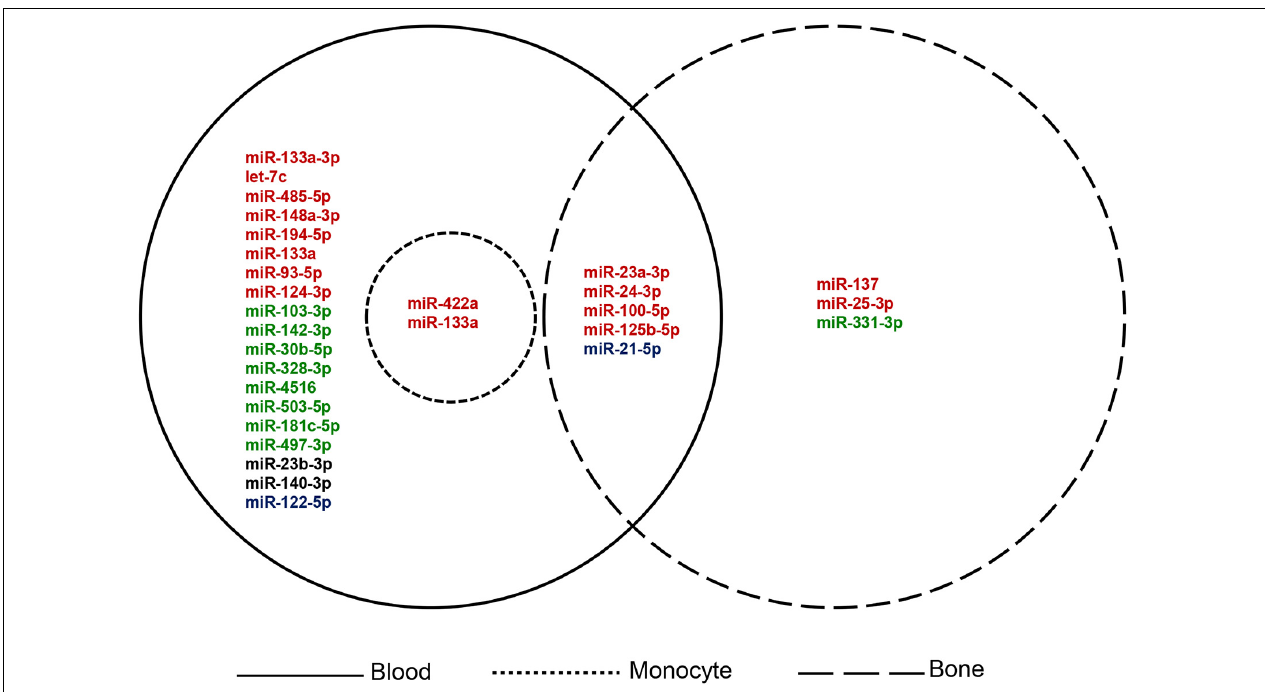
FIGURE 2 | Classification of the collected OP miRNAs based on sample source. Red: up-regulated; green: down-regulated; blue: up-regulated and down-regulated in different studies; black: expression level not available.